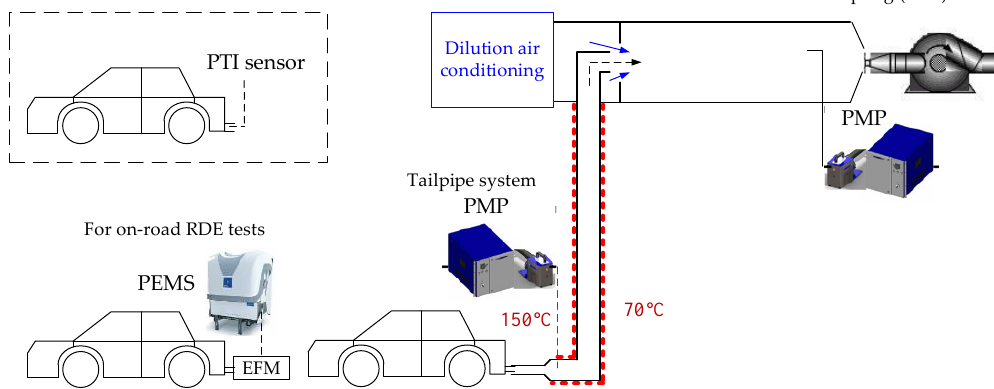
Figure 1. Experimental setup of this study in the laboratory or on the road. In the laboratory the particle number systems (PMP) where connected to the tailpipe and / or to the full dilution tunnel (CVS). On the road particle number PEMS were used. The typical new PTI setup, used in some studies of the literature, is also shown on the top left corner of the figure in dashed lines. CVS = Constant Volume Sampling; EFM = Exhaust Flow Meter; PEMS = Portable Emissions Measurement System; PMP = Particle Measurement Programme; PTI = Periodical Technical Inspection; RDE = Real-Driving Emissions.